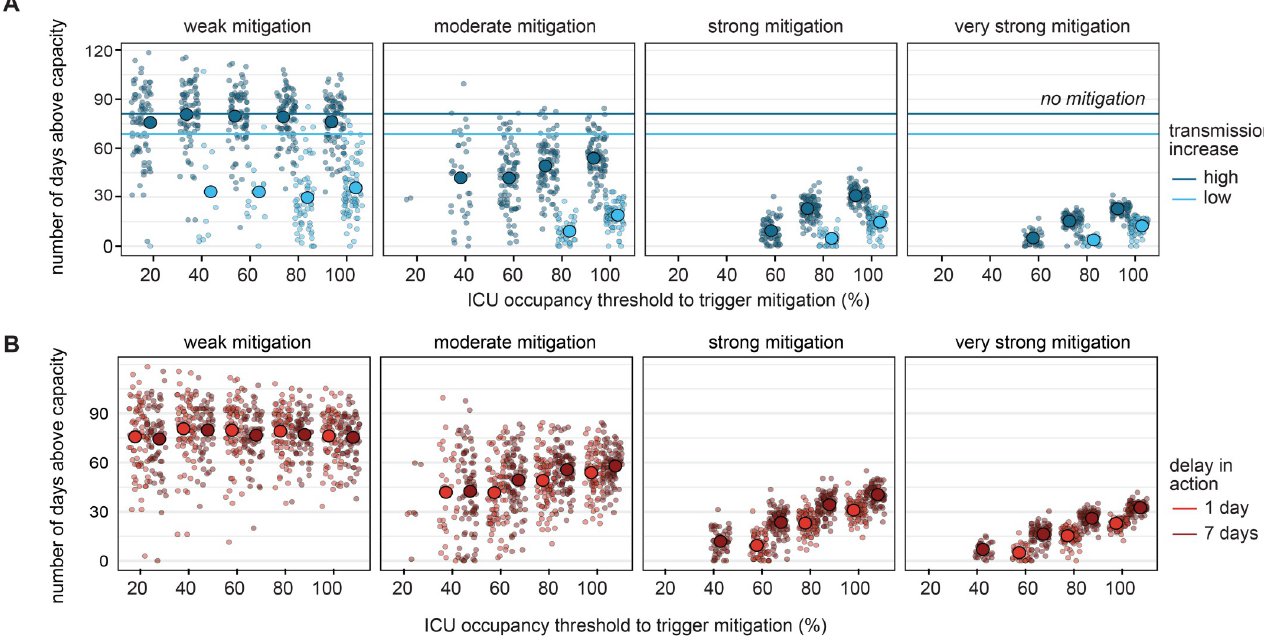
Fig 6. Number of days spent above ICU capacity under various possible response scenarios. A) Number of days above ICU capacity by transmission increase level with immediate mitigation. B) Number of days above ICU capacity by mitigation timeliness under high transmission increase. Shown: single trajectories and aggregated mean. The number of trajectories included in each scenario group is shown in Fig P in S1 Text.